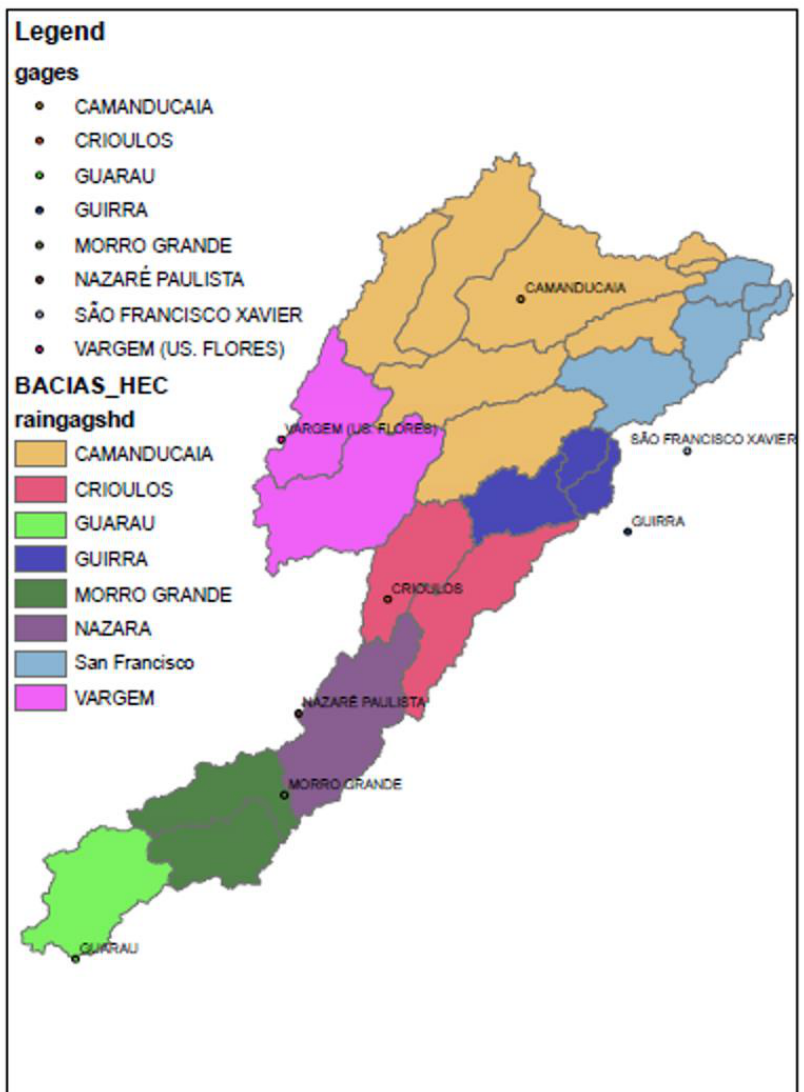
Figure A2. Rain gages of Cantareira Water Supply System.